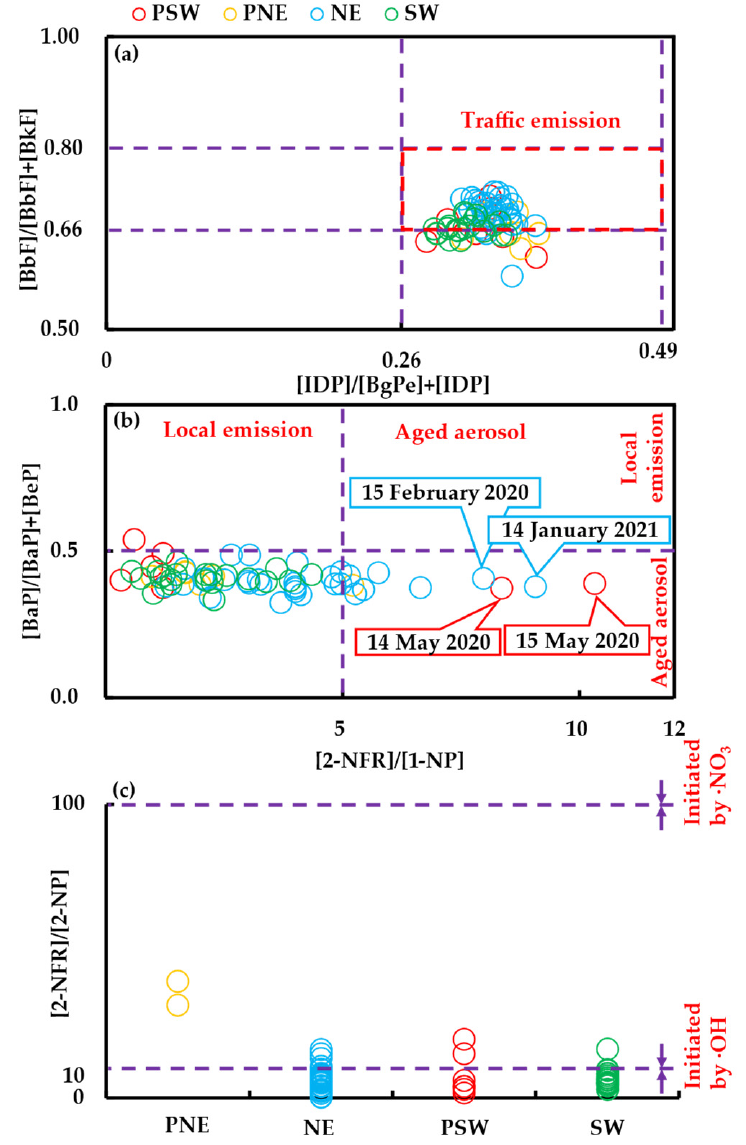
Figure 3. The distribution of diagnostic ratios of PAHs and NPAHs in four monsoon seasons in Singapore: ( a ) The values of the [BbF]/([BbF] + [BkF]) and [IDP]/([BgPe] + [IDP]) ratios; ( b ) The values of [BaP]/([BaP] + [BeP]) and [2-NFR]/[1-NP] ratios; ( c ) the values of several [2-NFR]/[1-NP] ratio. The [2-NFR]/[2-NP] ratio is used to clarify the advantages of atmospheric reactions initiated by · OH (close to 10) and NO 3 · (close to 100) radicals because 2-NP and 2-NFR are formed in the atmosphere mainly by the · OH radical and NO 3 · radical pathways